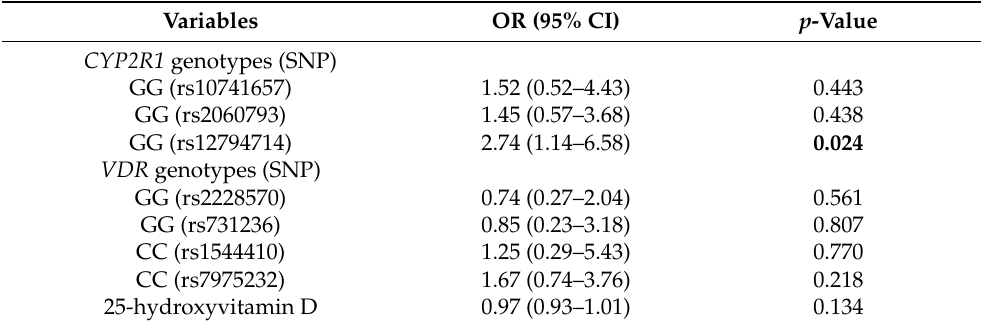
Table 3. Logistic regression analysis of the association of the CYP2R1 and VDR polymorphisms and 25(OH)D levels with MS